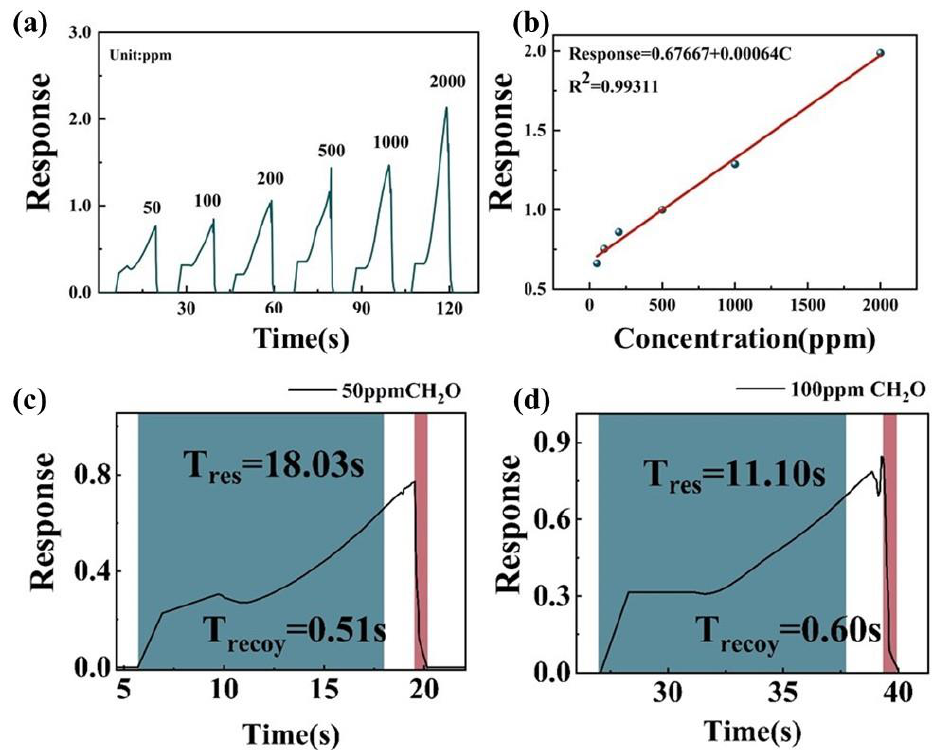
Figure 6. ( a ) Relationship between S2 response to CH 2 O at room temperature and the vapor concen- tration. ( b ) Fitted plot of response concentration of CH 2 O. ( c , d ) Response–recovery times of S2 at 50 ppm and 100 ppm, respectively.